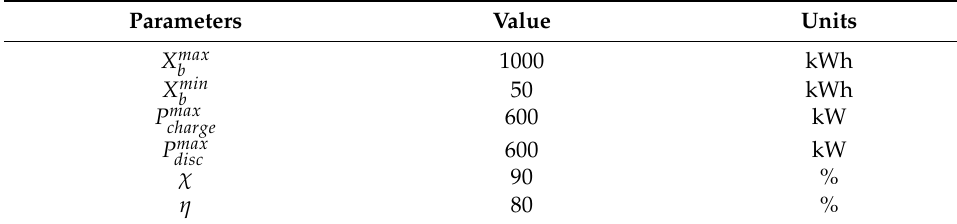
Table 4. Parameters of electrical energy storage.